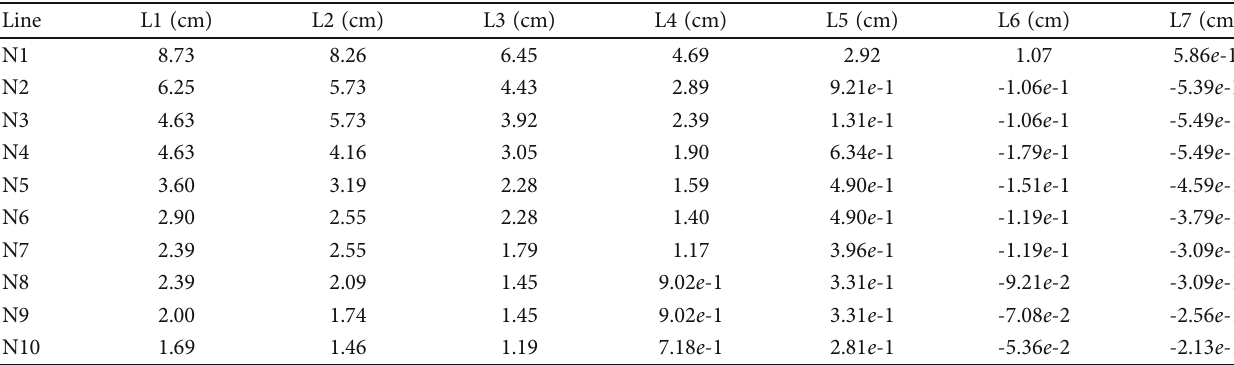
Figure 6: The radial displacement. Table 7: The radial displacements of each survey line.